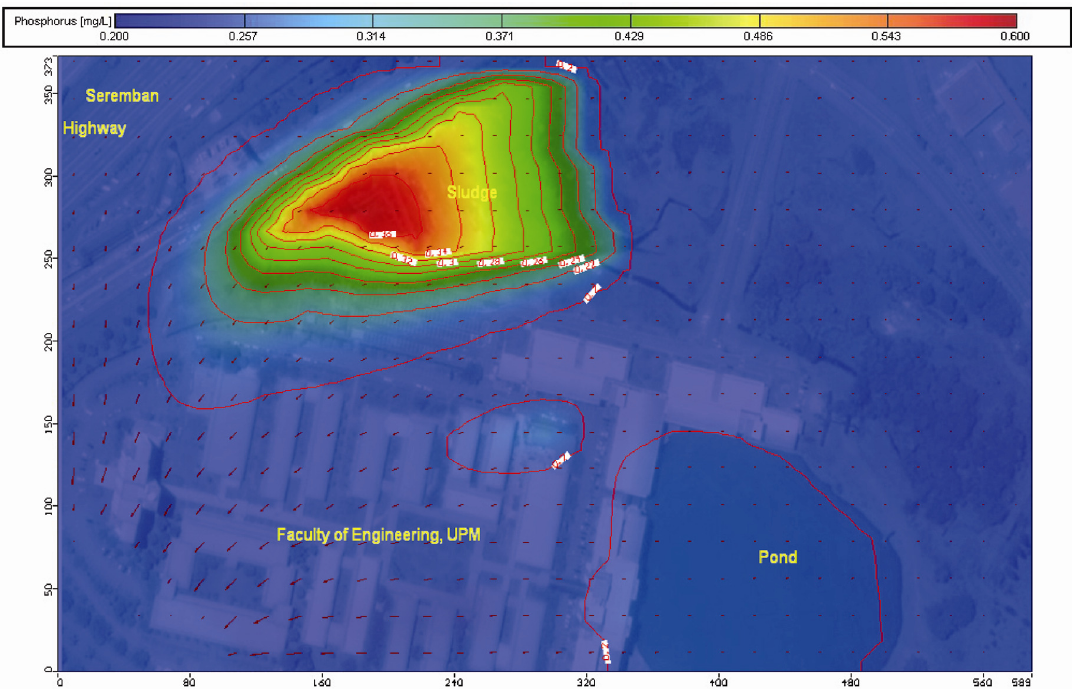
Fig. 6. Result of simulation of contamination migration in Layer No. 2 after 50